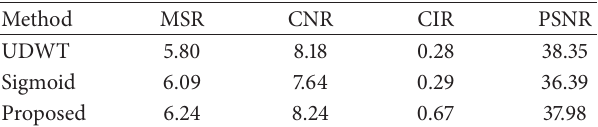
Table 3: Comparison of image processing methods in terms of 4 quantitative quality metrics for mammograms.